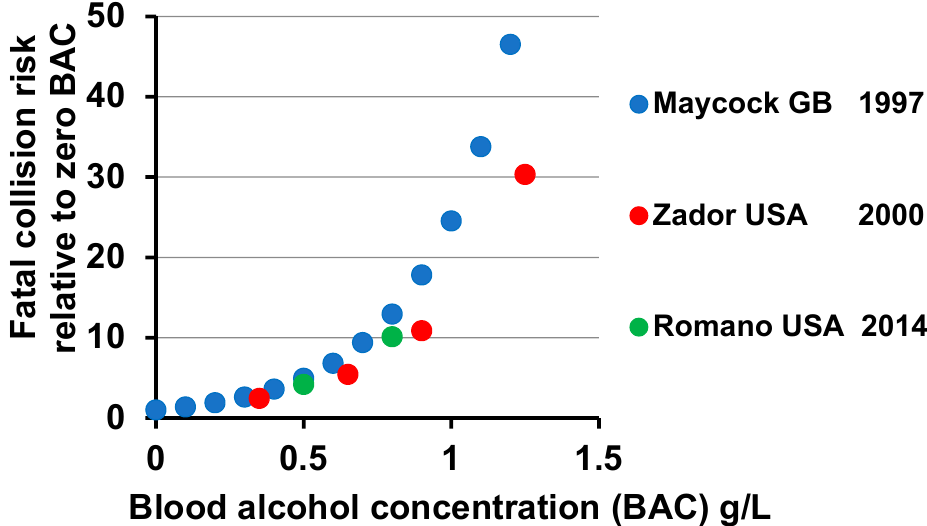
Figure 2. Variation in the risk of involvement in a fatal collision with level of alcohol in the blood as estimated by Maycock [11], Zador et al. [12] and Romano et al. [13].